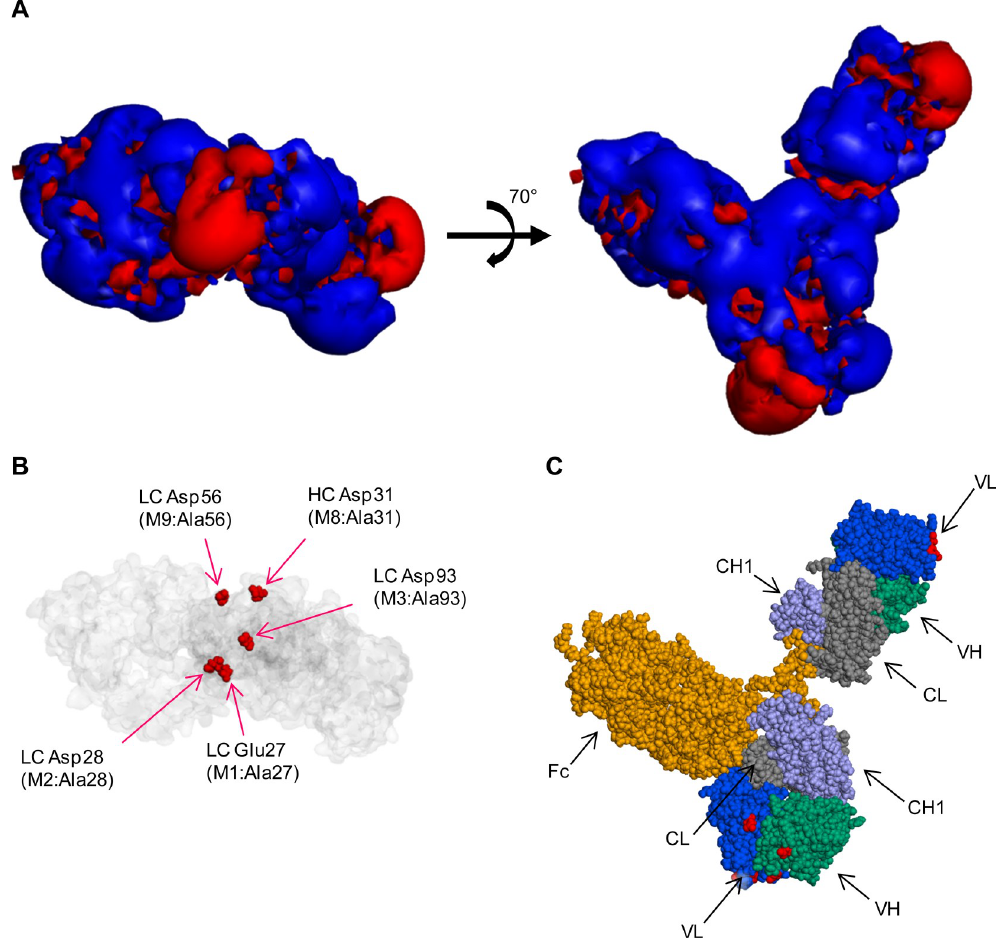
Fig 1. Charge distribution on the surface of WT mAb1. Three representations of full-length IgG were used. (A) Rotational view of mAb1 isovalue surface. The red and blue contours indicate the − 1 k B T / e (negative) and +1 k B T / e (positive) isosurface potentials. (B). Connolly surface (transparent gray color) with Corey–Pauling–Koltun (CPK) representation (red color) of five negatively charged amino acids: light chain (LC) Glu27, LC Asp28, LC Asp93, LC Asp56, and heavy chain (HC) Asp31. (C) CPK representation of the WT, with yellow = Fc, blue = VL, green = VH, light purple = CH1, gray = CL, and red = mutated residues on Fv regions. mutants, and 674 debye for the triple-charge deletion mutant (Table 1). The angle between the WT and mutant dipole moments for M8 and M9 was larger compared with that for other sin- gle-charge deletion mutants: M1, M2, and M3.